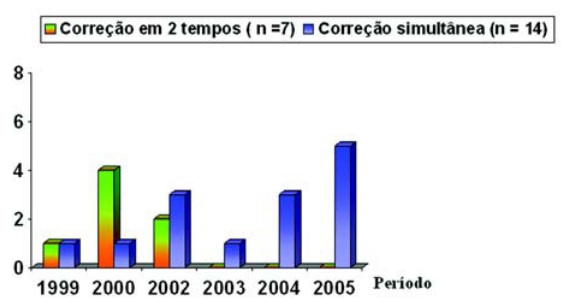
Fig 2. - TGA + obstrução do arco aórtico – estratégia cirúrgica x tempo de